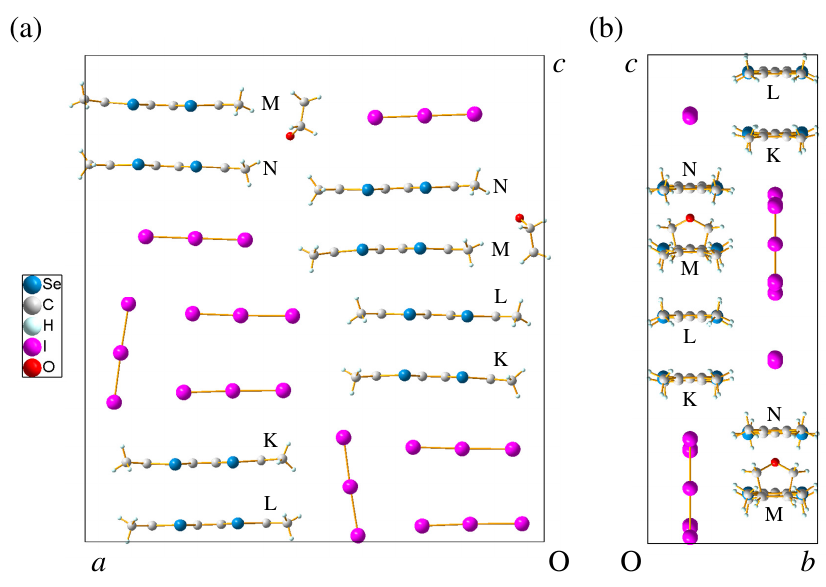
Figure 8. The crystal structure of (TMTSF) 4 (I 3 ) 4 · THF at room temperature viewed along ( a ) the b -axis and ( b ) a -axis, respectively. The crystallographically independent TMTSF molecules are labeled K, L, M, and N. The molecules in a half unit cell is shown in each of ( a , b ).